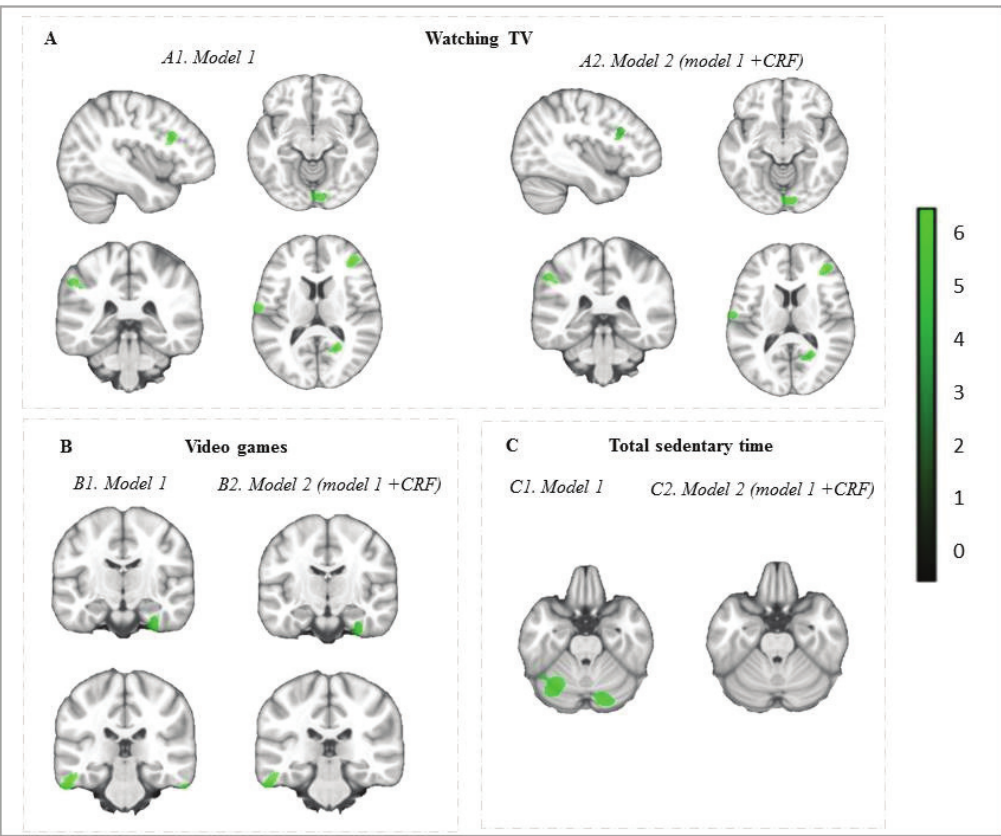
sedentary behavior and gray matter volume. In model 1 (i.e., adjusting for sex, PHV, parental education and BMI), a greater amount of time watching TV was associated with lower gray matter volumes ( p < 0.001, k = 77) in six clusters with β ranging from − 0.314 to − 0.489 and cluster sizes between 106 voxels and 323 voxels, specifically in the frontal regions (i.e., the middle frontal gyrus and the pars triangularis of the inferior frontal gyrus), the parietal regions (i.e., the inferior parietal gyrus and the 2, after further adjustment for cardiorespiratory fitness, the same six clusters remained significant ( p < 0.001, k = 75) with β ranging from − 0.312 to − 0.488 and cluster sizes between 99 voxels and 340 voxels.